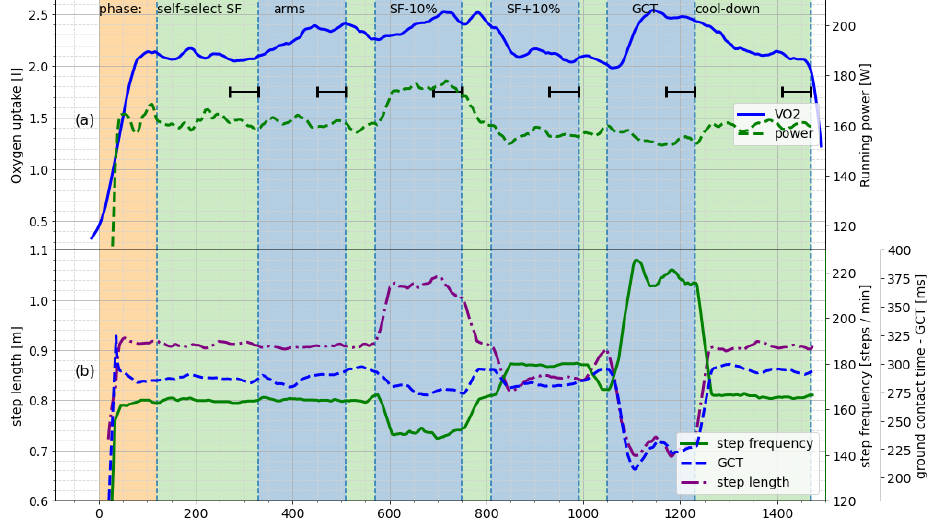
Figure 1. Protocol for the running economy variation test, all performed at a fixed speed. Example of a single subject. Raw values for all measurements are plotted over time (measured at 1 Hz). ( a ) Oxygen consumption and power output during the running conditions. ( b ) Spatiotemporal running parame- ters in reaction to instructions for the experimental conditions. ˙VO 2 for self-selected SF, 4 conditions and cool-down (average for last minute of each phase, cf. horizontal lines, * = significant difference): 2.06, 2.36 *, 2.49 *, 2.08, 2.47 *, 2.07. P W : 160.62, 159.84, 170.88, 156.34, 155.62, 160.58. Best viewed in